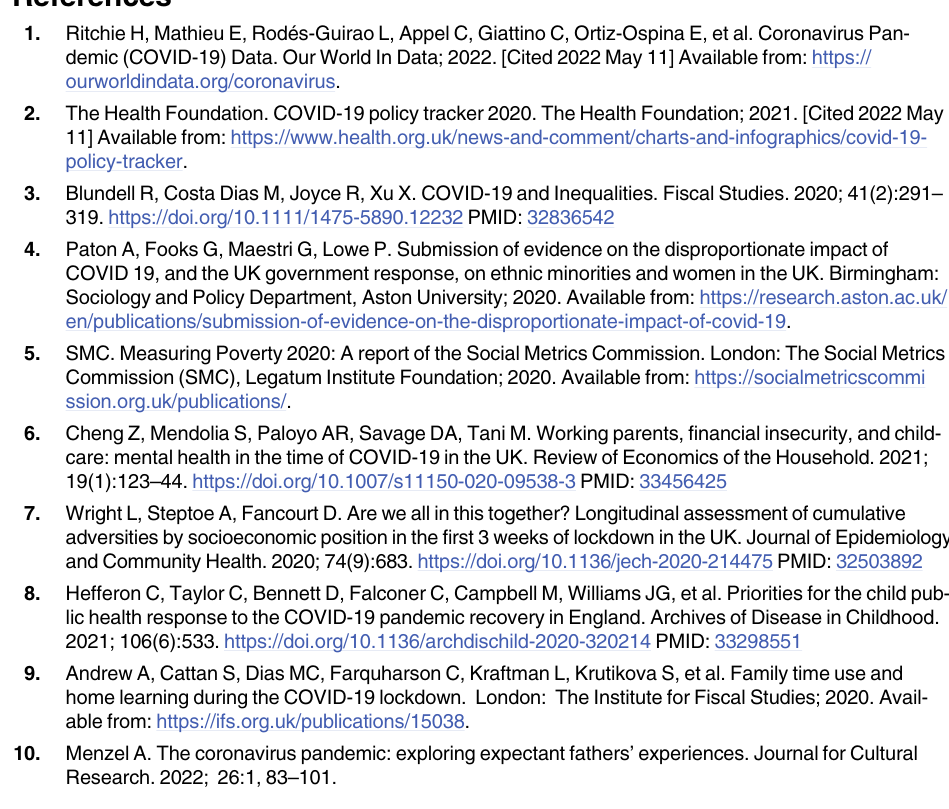
S2 Table. Impact of COVID-19 on household ability to cover expenses by maternal socio- demographic characteristics in the COVID-19 New Mum Study; % (n). S3 Table. Impact of the pandemic on partner employment by household income in the COVID-19 New Mum Study; % (n). S4 Table. Reported impact of the pandemic on employment and related factors in the UK COVID-19 New Mum